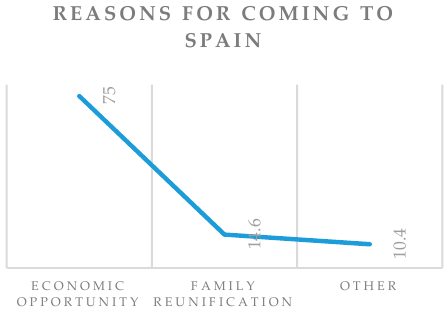
Figure 6. Results for “reasons for coming to Spain”.